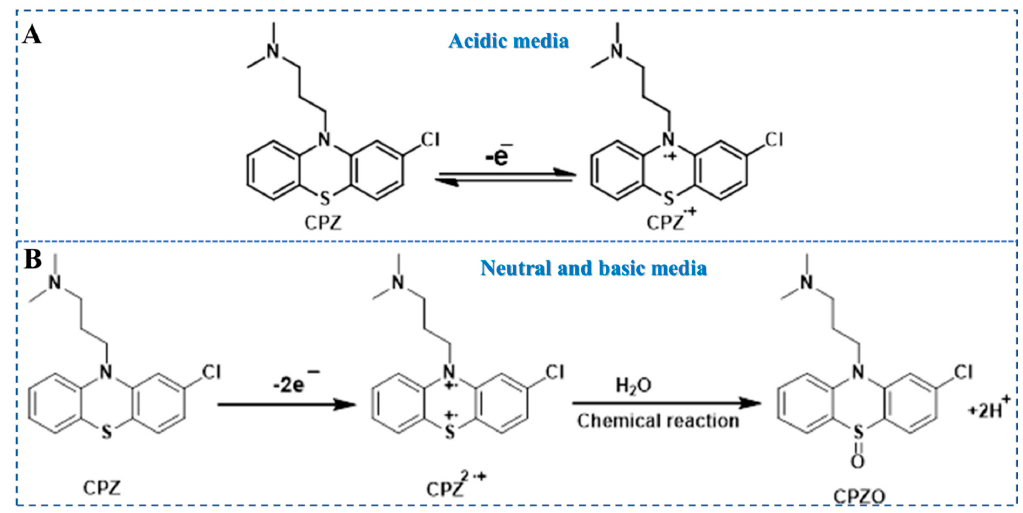
Scheme 2. Possible electrochemical mechanism of CPZ in ( A ) acidic media, ( B ) neutral and basic media at N-CDs/Cu 2